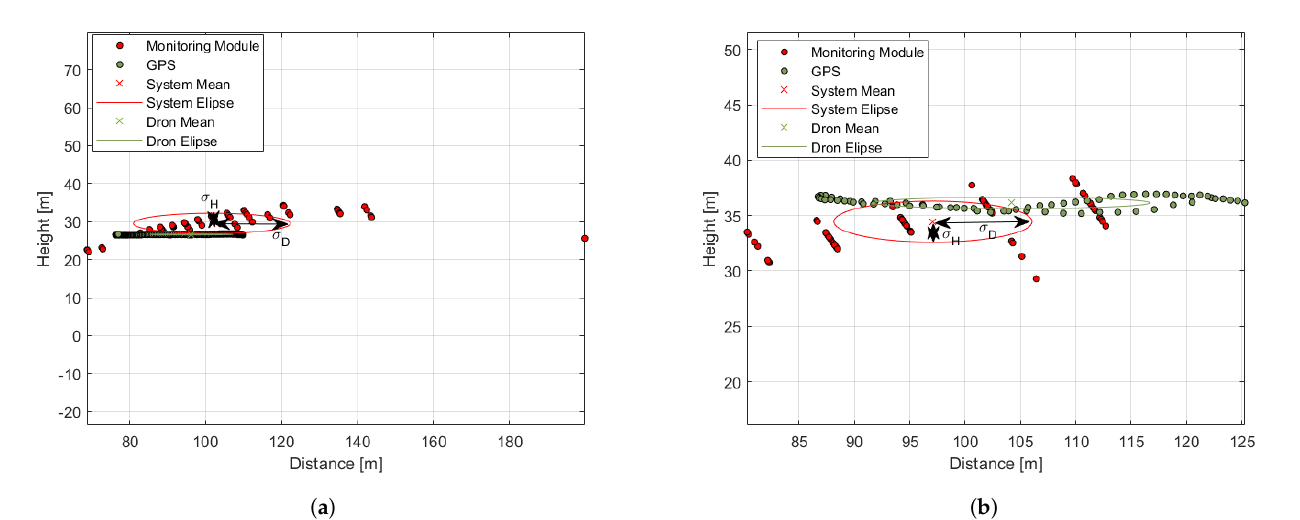
Figure 16. The graphical illustration of the tests results. Distance from a monitoring module vs. the height of the drone during the test. Green dots: GPS data; red dots: data from the module. The corresponding color ellipses illustrate the standard deviations of the respective distance and height measurements. ( a ) Scenario III; ( b ) Scenario